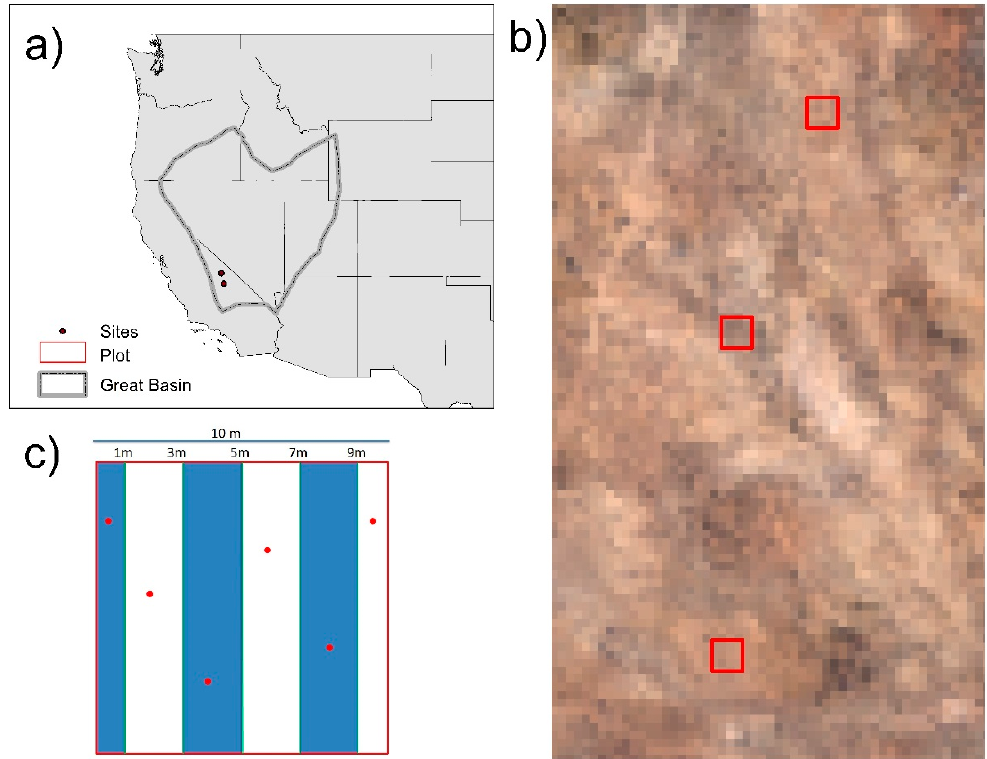
Figure 1. ( a ) Location of two research sites in California, USA; ( b ) examples of plots (red boxes) overlaid on top of AVIRIS-NG true color images; ( c ) field sampling scheme in 10 × 10 m plots. Blue strips represent spaces between line transects, and red dots represent sampled shrubs between intersects.